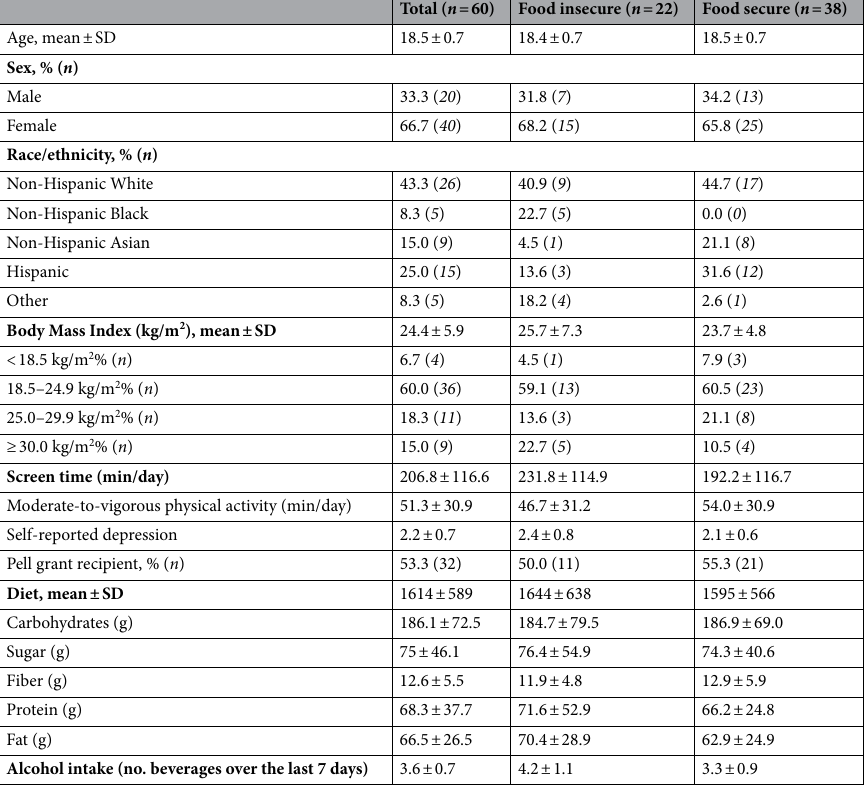
Table 1. Participant characteristics by food insecurity status. SD standard